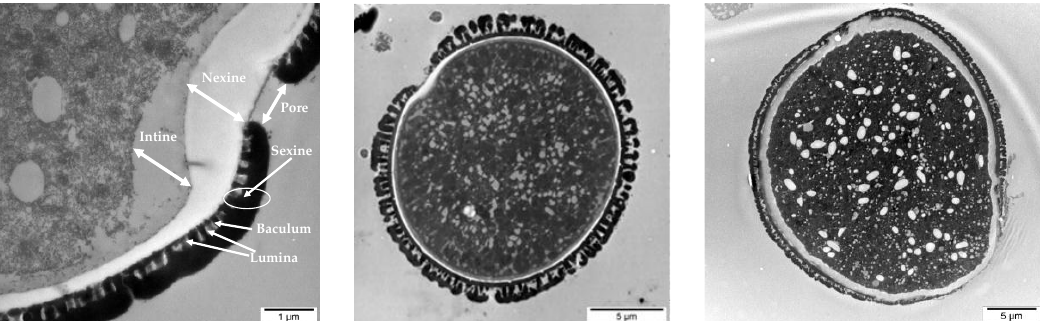
Figure 5. Control sample of unfermented pollen. The arrows show the external wall exine, consisting of sexine and nexine, and the inner wall intine. Additional ultrastructural characteristics of pollen, lumina and baculum are spotlighted. Middle and right pictures illustrate representative aspects of the analyzed pollen grains.